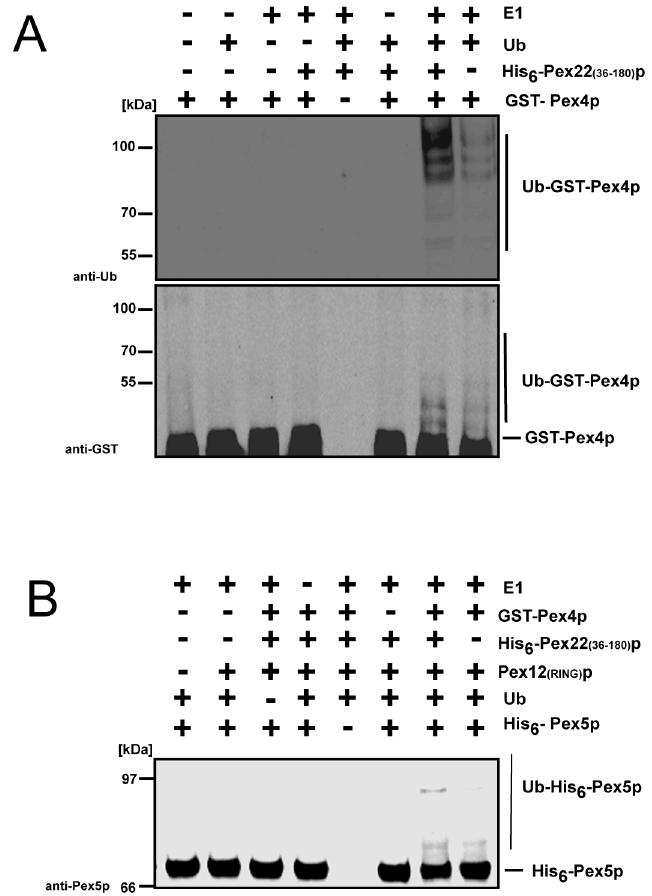
Figure 3. Pex22(C)p enhances autoubiquitination of Pex4p and Pex4p/Pex12p-catalyzed ubiquitination of the PTS1-receptor invitro . ( a ) Autoubiquitination of GST-Pex4p. The effect of Pex22(C)p on the autoubiquitination of GST-Pex4p was examined in vitro using heterologously expressed and purified proteins as indicated. Autoubiquitination of GST-Pex4p depends on the presence of E1 and ubiquitin (Ub). As shown by immunoblot analysis with antibodies against GST and Ub, the autoubiquitination of GST-Pex4p is significantly enhanced in the presence of His-Pex22(C)p. ( b ) Ubiquitination of the PTS1-receptor Pex5p. Recombinant proteins were used for in vitro ubiquitination of Pex5p, which depends on the presence of E1, GST-Pex4p, Ub as well as the RING-domain of the E3 enzyme Pex12p and was significantly enhanced in presence of His- Pex22(C)p.